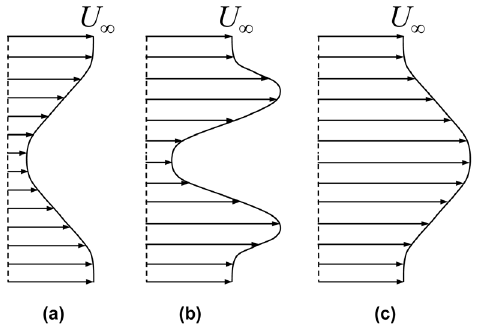
Figure 14. Schematic examples of a drag wake (a), momentum- less wake (b) and a jet wake (c).